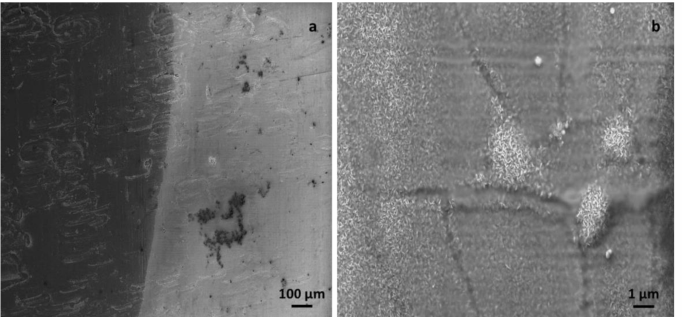
Figure 9. ( a ) Micrographs of LF surfaces after freeze/thaw test; the dark zone was in contact with water during icing while the clear one was water-free during the test. ( b ) High magnification of the frozen zone which exhibits the flattening of the flower-like structure after the test.